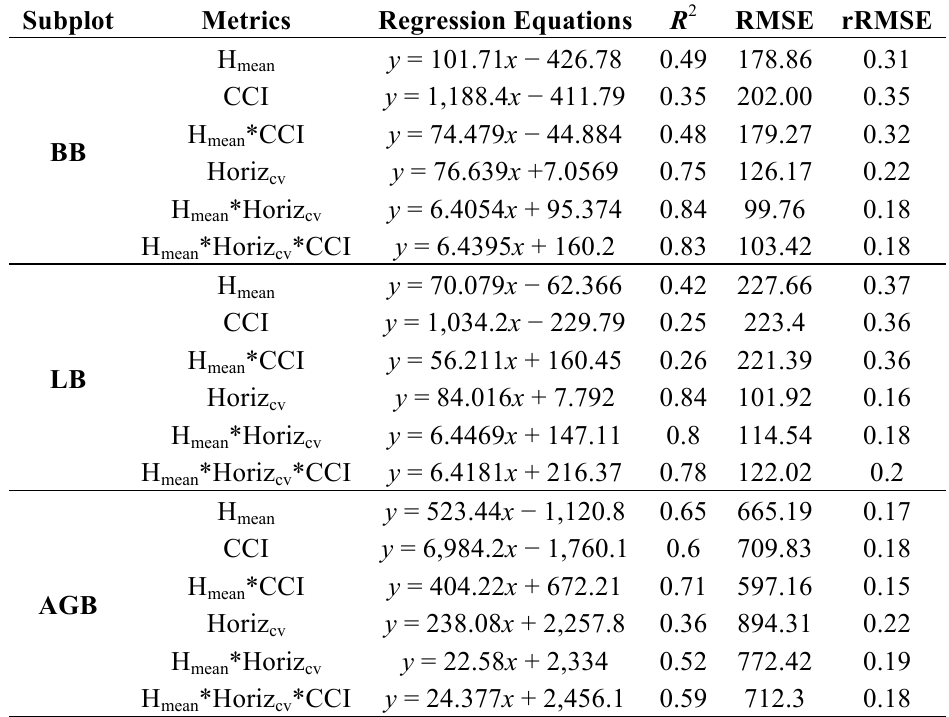
Table 5. Regression models developed from biomass components and LiDAR metrics at the subplot